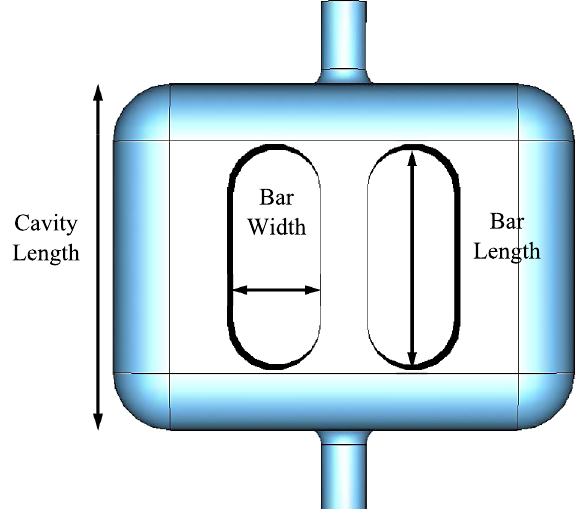
FIG. 13. Design parameters of optimization for the parallel-bar design with rectangular outer conductor and race-track-shaped loading elements [Design (B)].